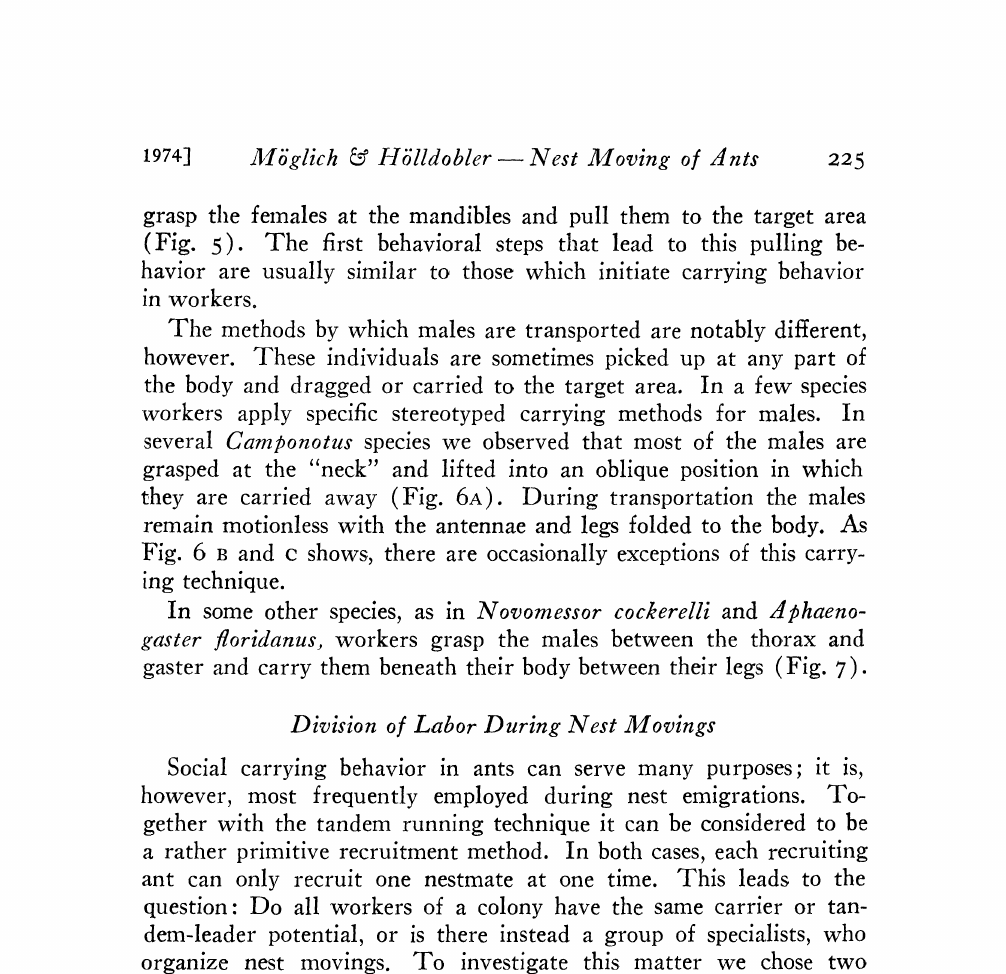
jerking response for 2-3 seconds. 2. The recruiter grasps the nestmate at the mandibles and pulls it back for about 2-20 cm. 3. When the recruiter turns, it holds the nestmate with a firm grip. The nestmate is thereby slightly lifted. 4. The nestmate folds its legs and antennae tightly to the body and rolls its gaster inward. 5. In this posture it is carried to the target area. The arrows indicate the direction of the movements. These sequences were based on a film